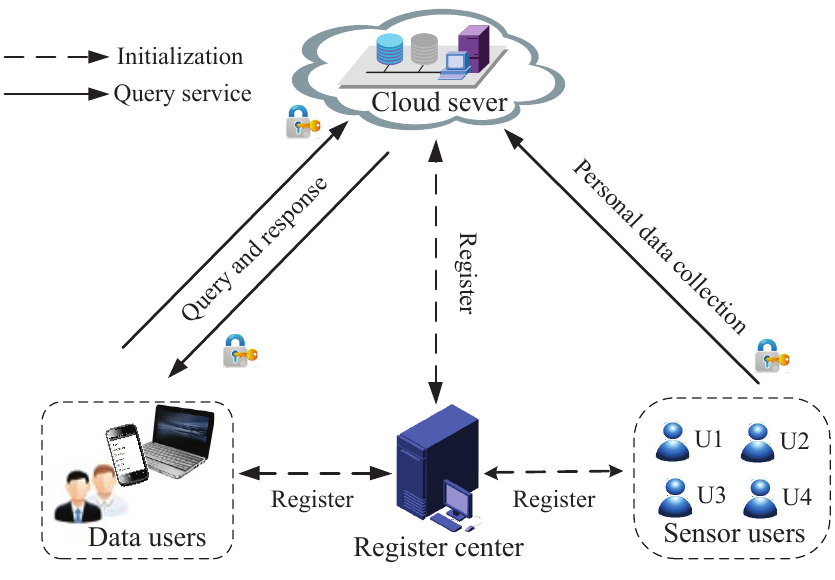
Figure 2. System model under